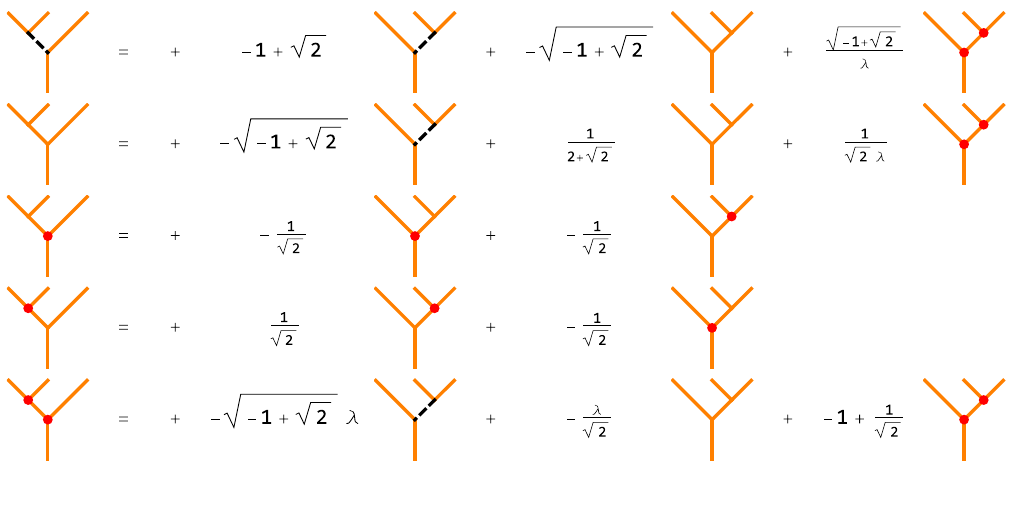
Figure 11 . The nontrivial F moves in the child